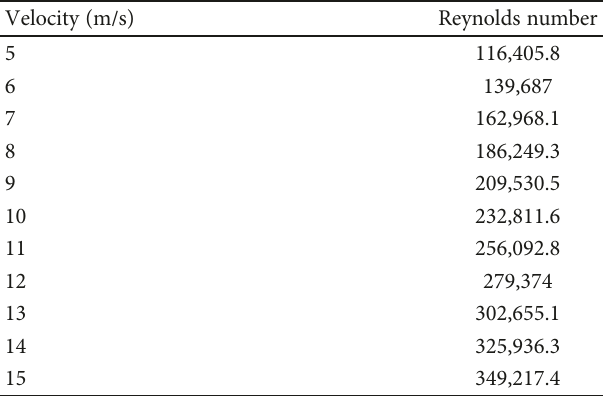
e ff ects of air fl ow over the actual installation con fi guration of modules in tilted mode.